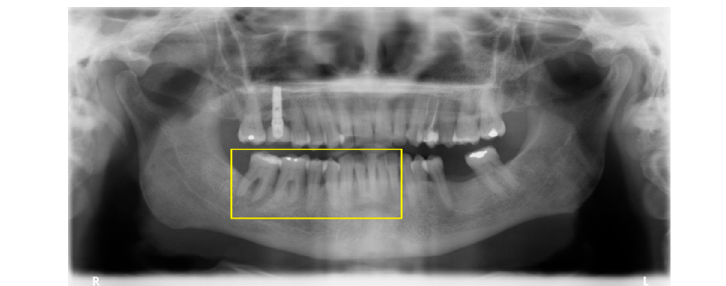
Figure 4. Orthopantomography at diagnosis (two years after baseline) with the patient exhibiting a significant bone loss in the segment marked with a yellow box.